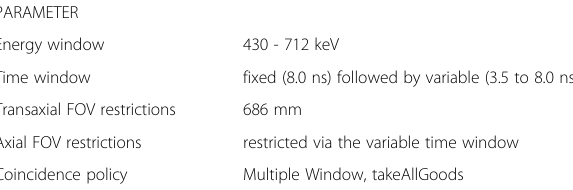
Table 2 (abstract A12). Parameters used for the coincidence processor